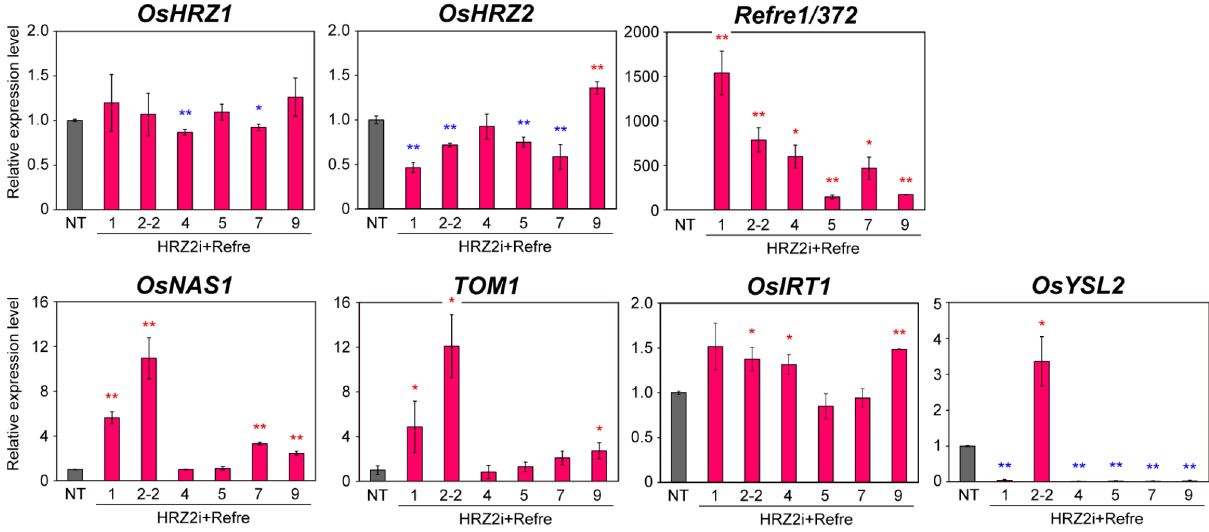
Fig. 2 Expression levels of Fe-related genes in the roots of the HRZ2i + Refre lines. Transcript levels of OsHRZ1 , OsHRZ2 , Refre1/372 , OsNAS1 , TOM1 , OsIRT1 and OsYSL2 were quantified by reverse transcription (RT)-PCR after Fe-sufficient hydroponic culture. Transcript abundance was normalized to rice α-2 tubulin and expressed as a ratio to the NT. The means ± SD are shown (n = 3). Asterisks indicate significant differences compared to the NT (two-sample Student’s t -test; * P < 0.05; ** P <